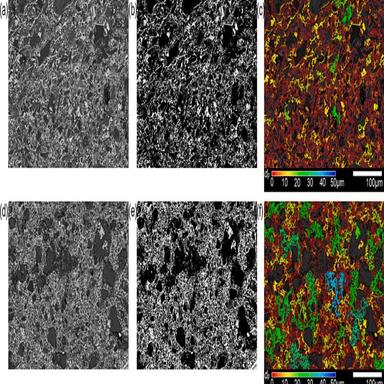
Visualisation of BSE images. (a) Typical 28-day BSE image of LC3 . (b) Binarised BSE image of (a). (c) Equivalent pore diameter-based colour map of metalintruded LC3 based on (b). (d) Typical BSE image of 28-day OPC. (e) Binarised BSE-image of (d). (f) Equivalent pore diameter-based colour map of metal-intruded OPC based on (e).